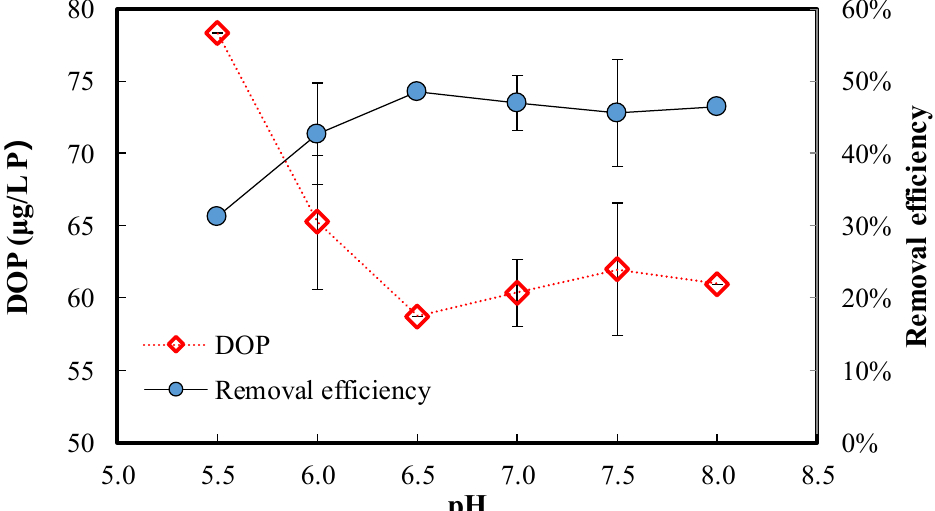
Figure 2. Residual DOP and DOP removal efficiency after ferrate (VI) treatment of secondary effluent at different initial pH. (DOP = 114 μ g/L as P; Fe (VI) = 5.0 mg/L; and initial pH = 5.5–8.0).